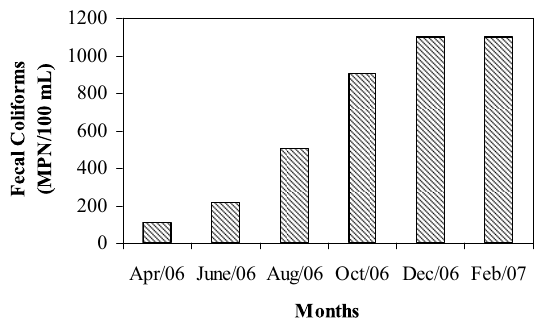
Fig. 4 – Fecal coliform values between April/06 and February/07, in the Caeté